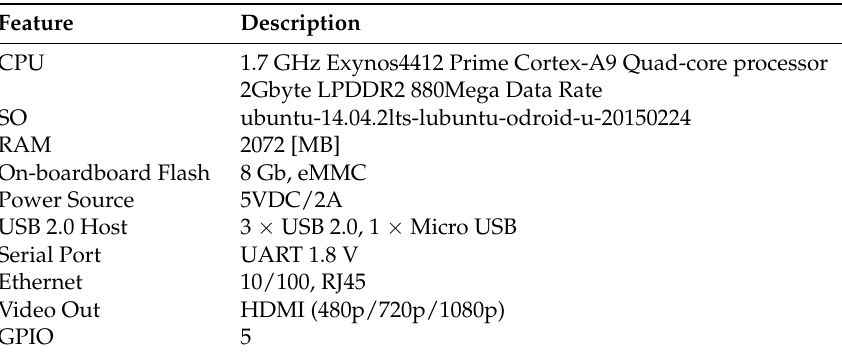
Table 1. Odroid-U3